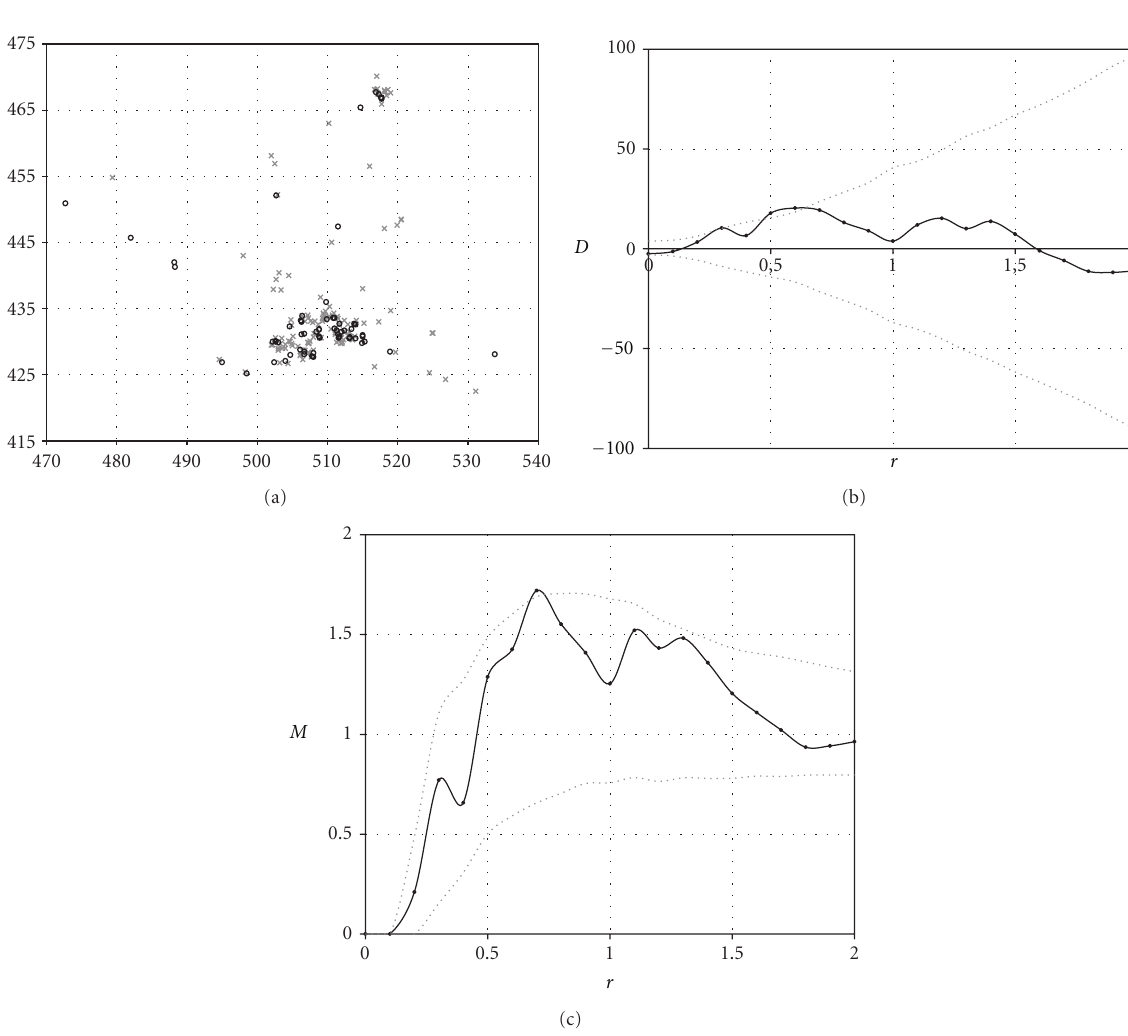
Figure 7: Childhood Leukemia epidemiology [6]. Map (a): cases (62 circles) are ill children locations; controls (141 crosses) are a sample of the whole population; distances are in km. Cases are significantly clumped, as shown by both functions D (b) and M (c), drawn as solid lines. M shows that in a 0.7km radius circle around each case, the case density is 70% higher than expected without aggregation ( M = 1 . 7). Confidence intervals for the null hypothesis of independence (dotted lines) are computed by Monte-Carlo simulations at the 10% risk level. The poor significance levels are due to too few